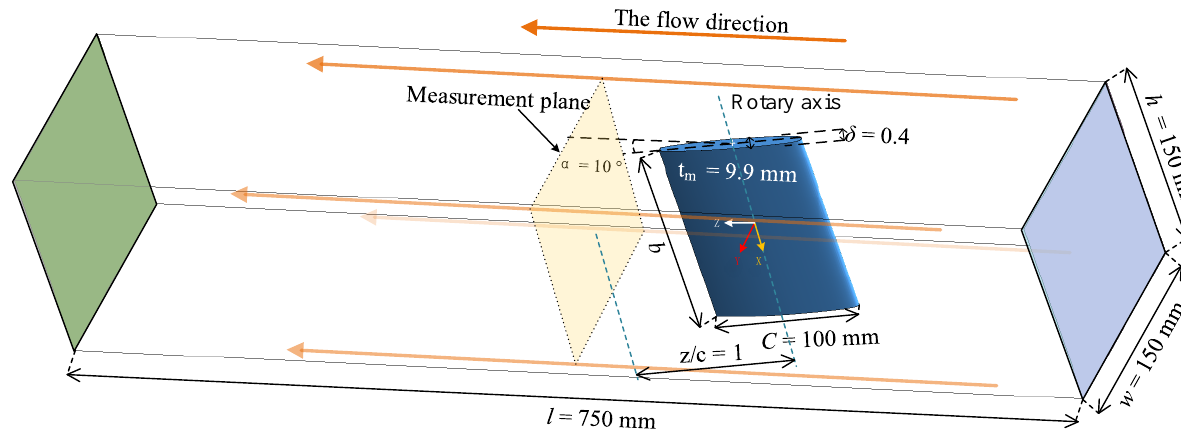
Figure 1. Computational fluid domain.